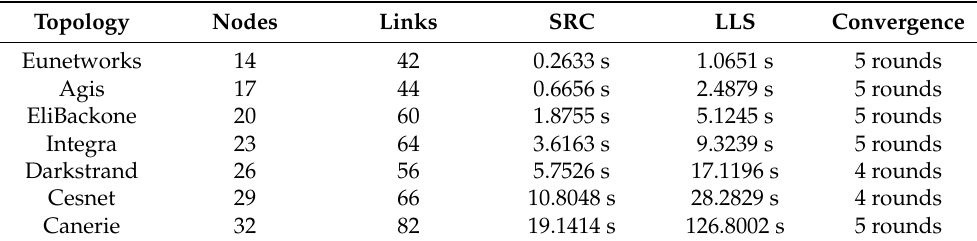
Table 2. Convergence time varies with network size.